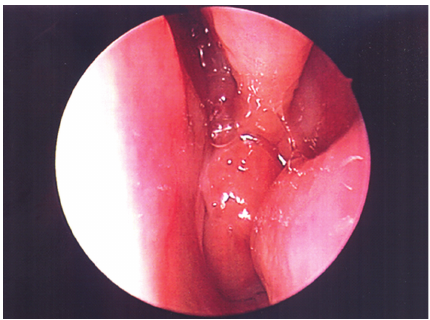
Figure 2: An endoscopic view using a 2.7 mm zero-degree rigid scope showing enlarged